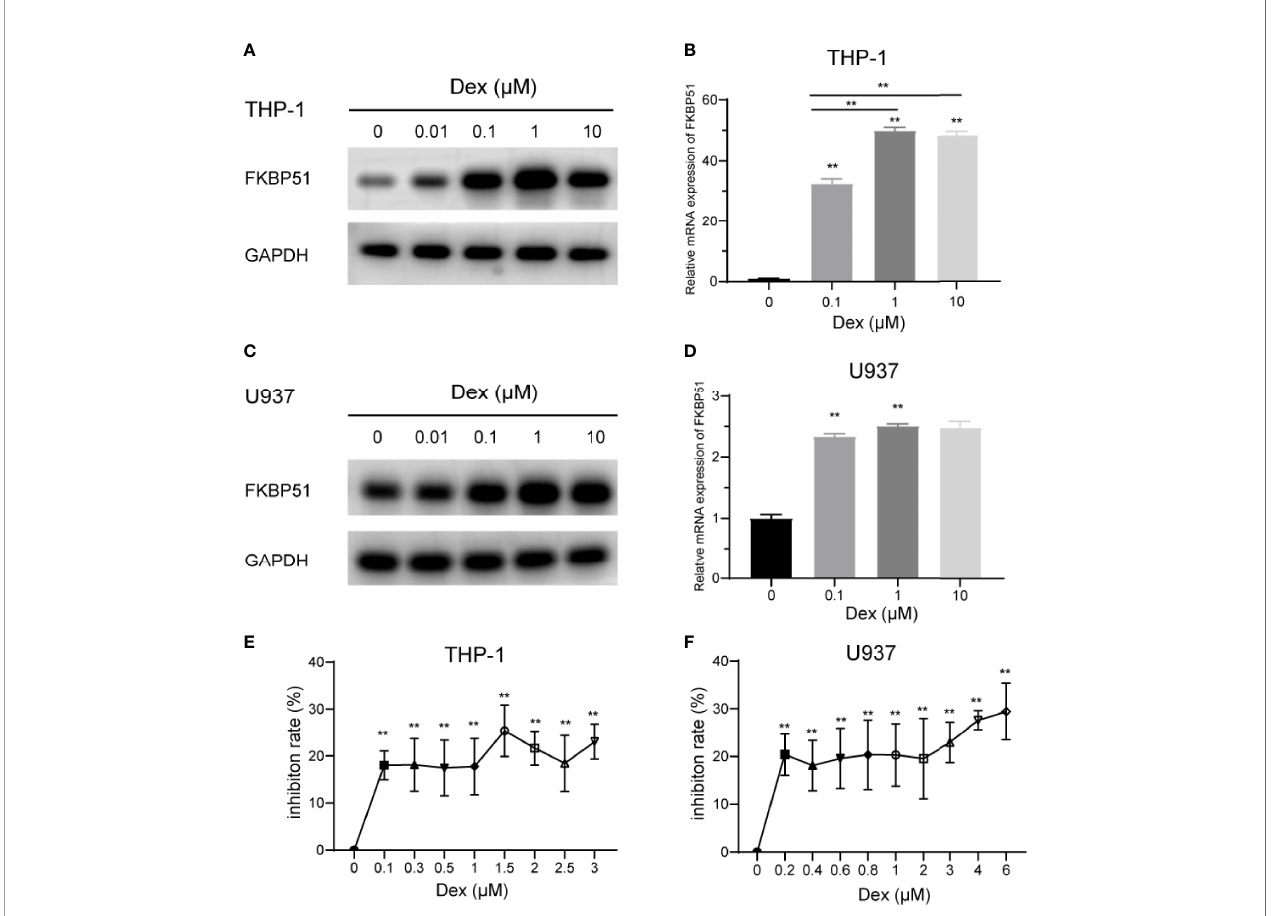
FIGURE 3 | Effect of dexamethasone on the FKBP51expression and proliferation of THP-1 and U937 cells. (A – D) The relative protein and mRNA quantities of FKBP51 in THP-1 and U937 cells conditioned with dexamethasone at a series of concentration relative to that in control cells. Dexamethasone upregulated FKBP51 expression in a dose-dependent manner. (E, F) After treatment with or without dexamethasone for 48 hours, the growth of AML-M5 cells was assessed by the CCK-8 assay. Dexamethasone slightly suppressed the cell viability of both cell groups while the inhibition rate did not increase with Dex concentration. The data are shown as the mean ± SD, and differences between groups were analyzed using independent sample Student ’ s t test and were considered to be signi fi cant at p < 0.05 (**p <